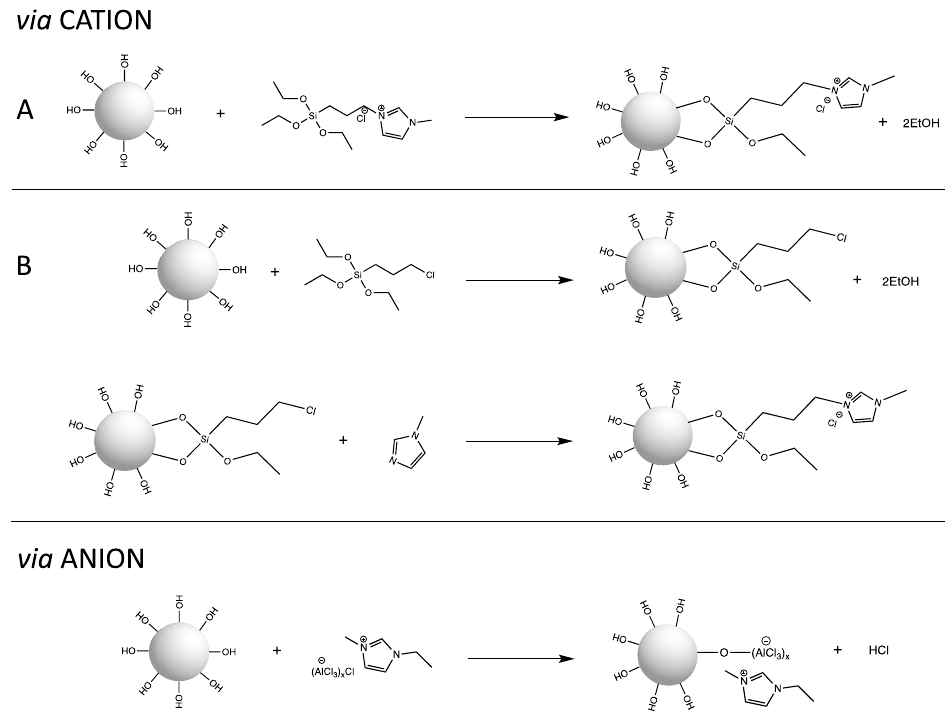
Figure 4. Covalent immobilization of ionic liquid on the silica surface via cation and via anion. Anchoring the IL into support can be obtained by direct immobilization of IL ( A ) or by building the IL structure on the support ( B ).